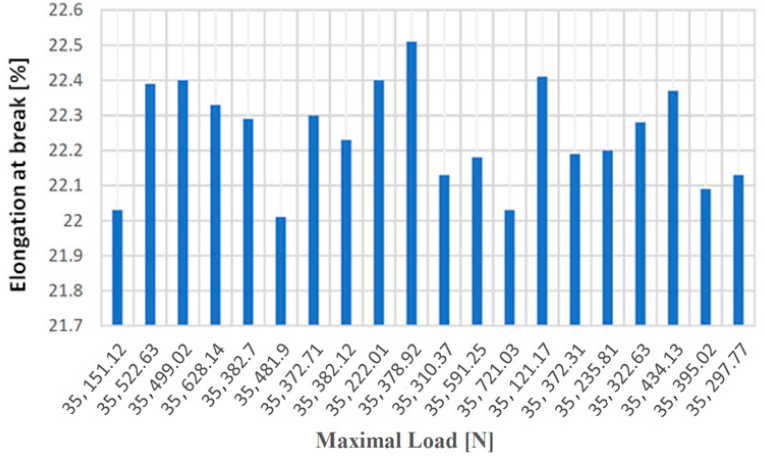
Figure 14. Elongation at break values at failure depending on the maximum forces applied to the 20 samples made of cast iron with lamellar graphite type EN-GJS-400-15. The values of the elongation at failure depending on the maximum forces applied to the 20 samples made of cast iron with spheroidal graphite type EN-GJS-400-15.